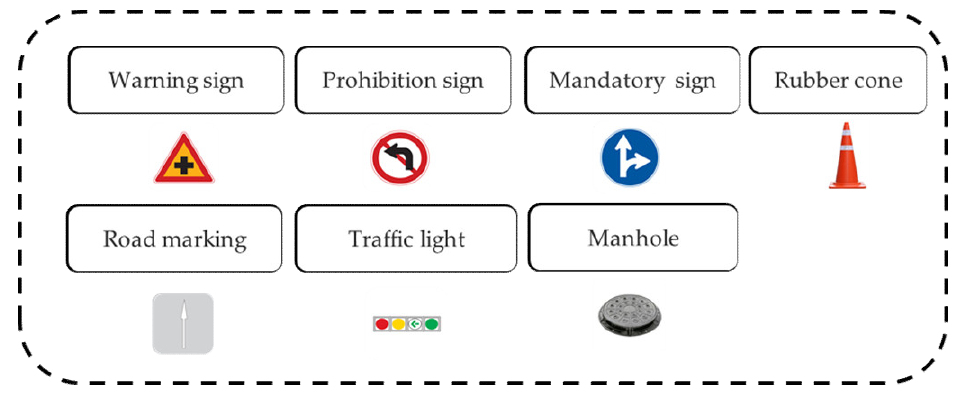
Figure 7. Training dataset group.